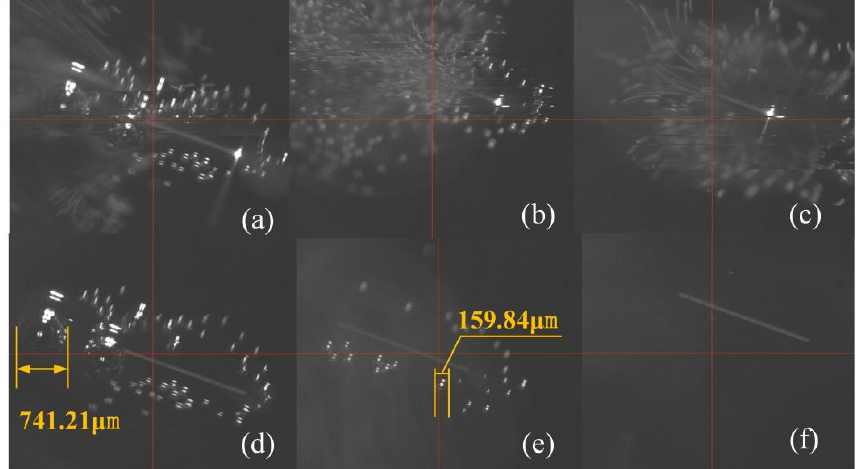
Figure 5. Attached bubbles under different liquid mediums: ( a ) deionized water in process; ( b ) 5.6 mol/L phosphoric acid solution in process; ( c ) absolute ethanol in process; ( d ) deionized water at 2 s; ( e ) 5.6 mol/L phosphoric acid solution at 2 s; ( f ) absolute ethanol at 2